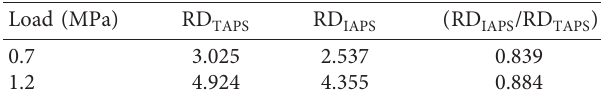
Table 13: Maximum rut depth ratio of the two pavement structures under the same wheel